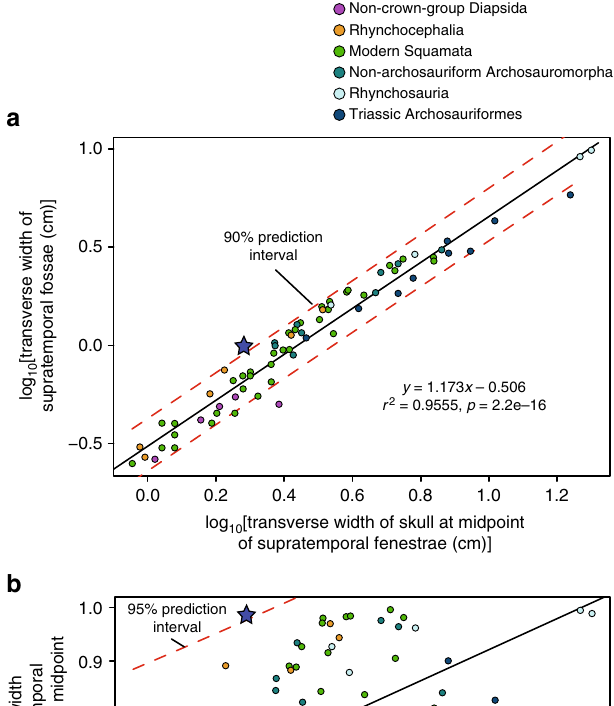
Fig. 3 Plots of metrics of overall skull size against supratemporal fossae dimensions. a Bivariate plot of the log-transformed transverse width of the postorbital portion of the skull (measured at the anteroposterior midpoints of the supratemporal fenestrae) against the log-transformed transverse width of the supratemporal fossae at the equivalent point. b Bivariate plot of the log-transformed transverse width of the postorbital portion of the skull against the proportional contribution of the supratemporal fossae to the postorbital breadth of the skull. c Bivariate plot of the log-transformed dorsal surface area of the skull against the proportional contribution of the supratemporal fossae to the dorsal surface area of the skull. On all plots, the blue star indicates the measurements for Colobops noviportensis